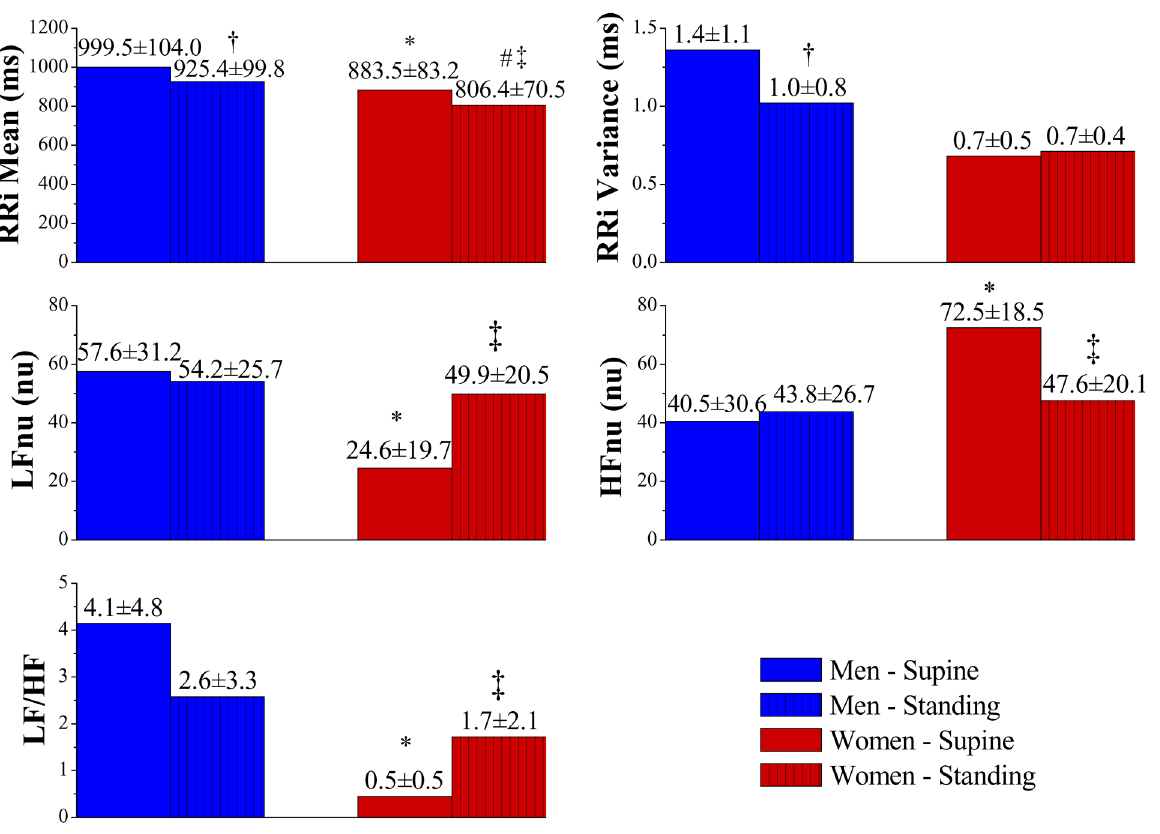
Figure 2. Heart rate variability determined by spectral analysis in the supine and standing positions. Data are reported as means ± SD. RRi = RR intervals; LFnu = low frequency in normalized units; HFnu = high frequency in normalized units; LF/HF = low frequency/ high frequency ratio. *P < 0.05 compared to men in the supine position; # P < 0.05 compared to men in the standing position; † P < 0.05 compared to men in the supine position; ‡ P < 0.05 compared to women in the supine position. Gender effect: unpaired t -test or Mann- Whitney test; position effect: paired t -test or Wilcoxon